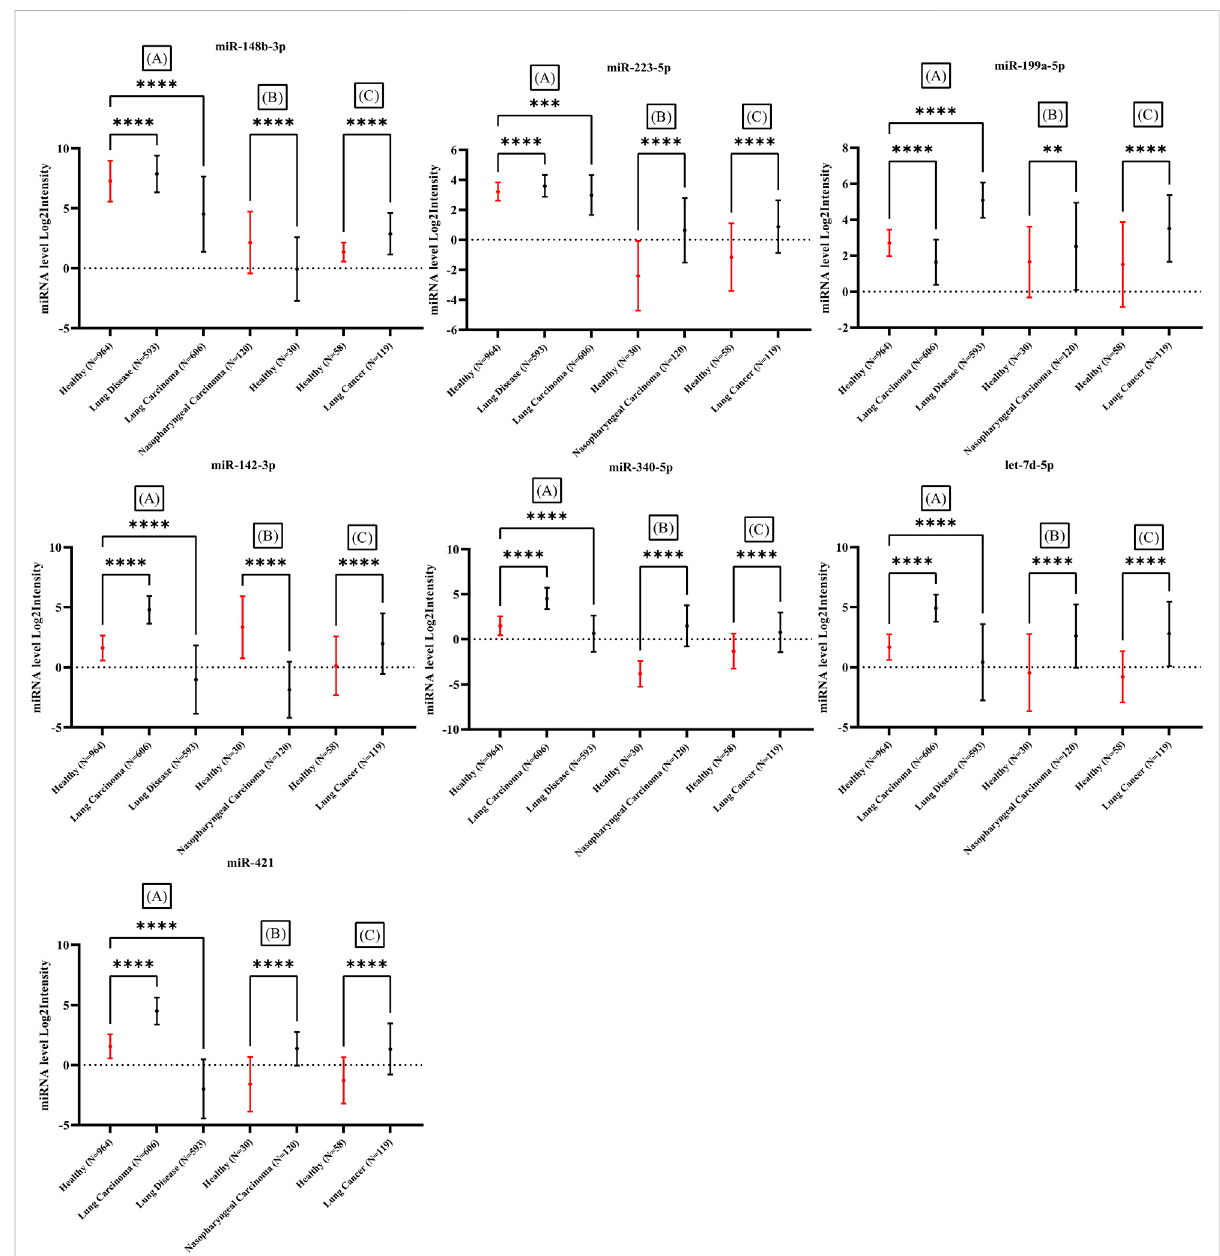
FIGURE 8 Expression difference in seven miRNAs in comparison between healthy individuals and several types of cancer in three studies. All samples obtained from whole blood of cancer patients. Signi fi cant difference demonstrated with p -value < 0.05 in all three studies. Three studies including (A): (Fehlmann et al., 2020), (B): (Wen, 2018) and (C): (Patnaik et al.,